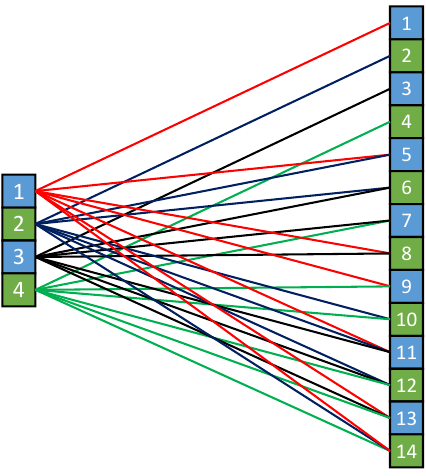
Figure 4—The connection between the C3 layer and S2